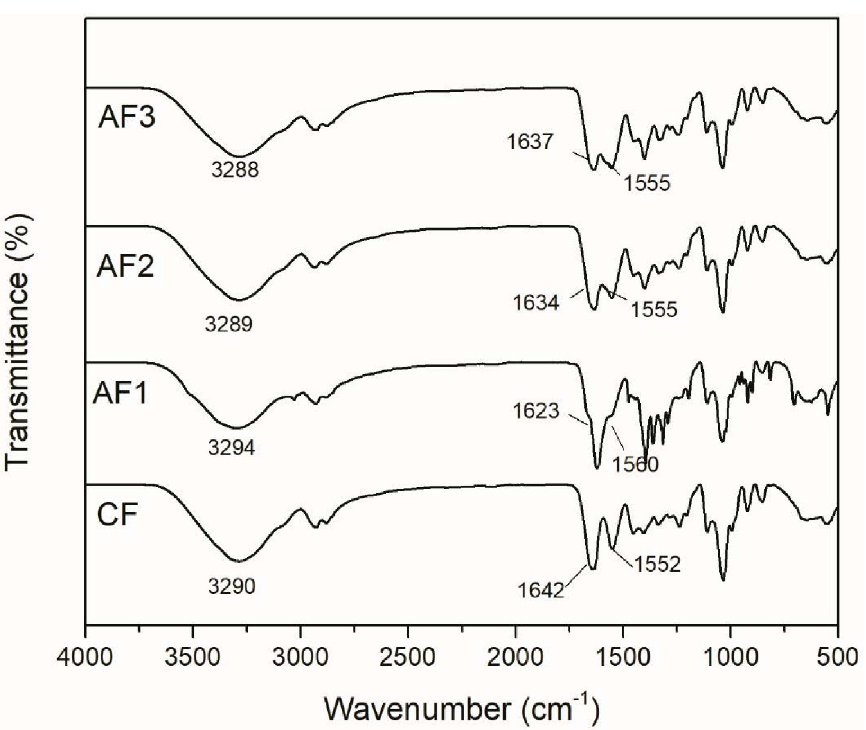
Fig 3. FT-IR of gelatin films studied. AF: Active Film, CF: Control